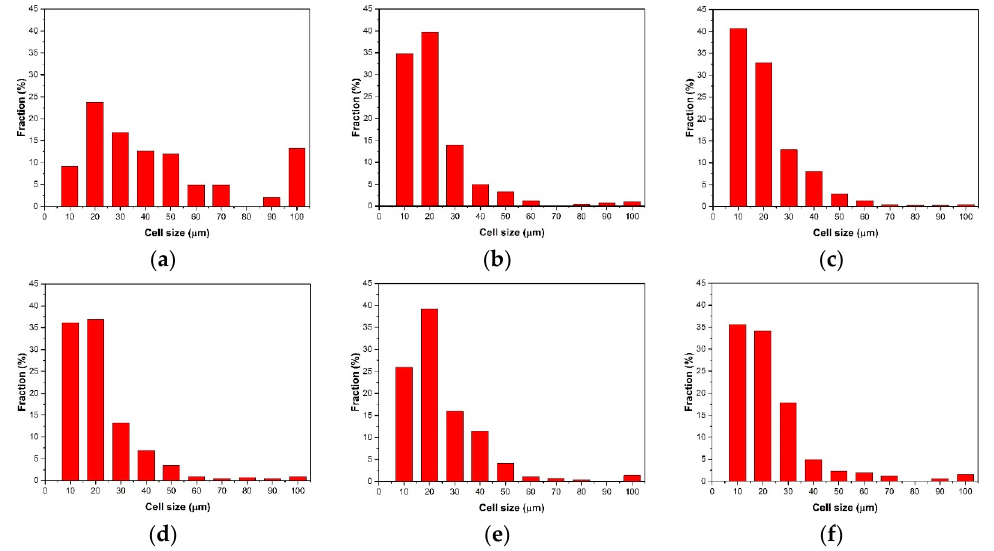
Figure 15. The cell size distribution of the transition layer of the vertical sections with the different contents of nano ‐ CaCO 3 : ( a ) 0 wt %; ( b ) 2 wt %; ( c ) 4 wt %; ( d ) 6 wt %; ( e ) 8 wt %; ( f ) 10 wt %. contents of nano-CaCO 3 : ( a ) 0 wt % ; ( b ) 2 wt % ; ( c ) 4 wt % ; ( d ) 6 wt % ; ( e ) 8 wt % ; ( f ) 10 wt %